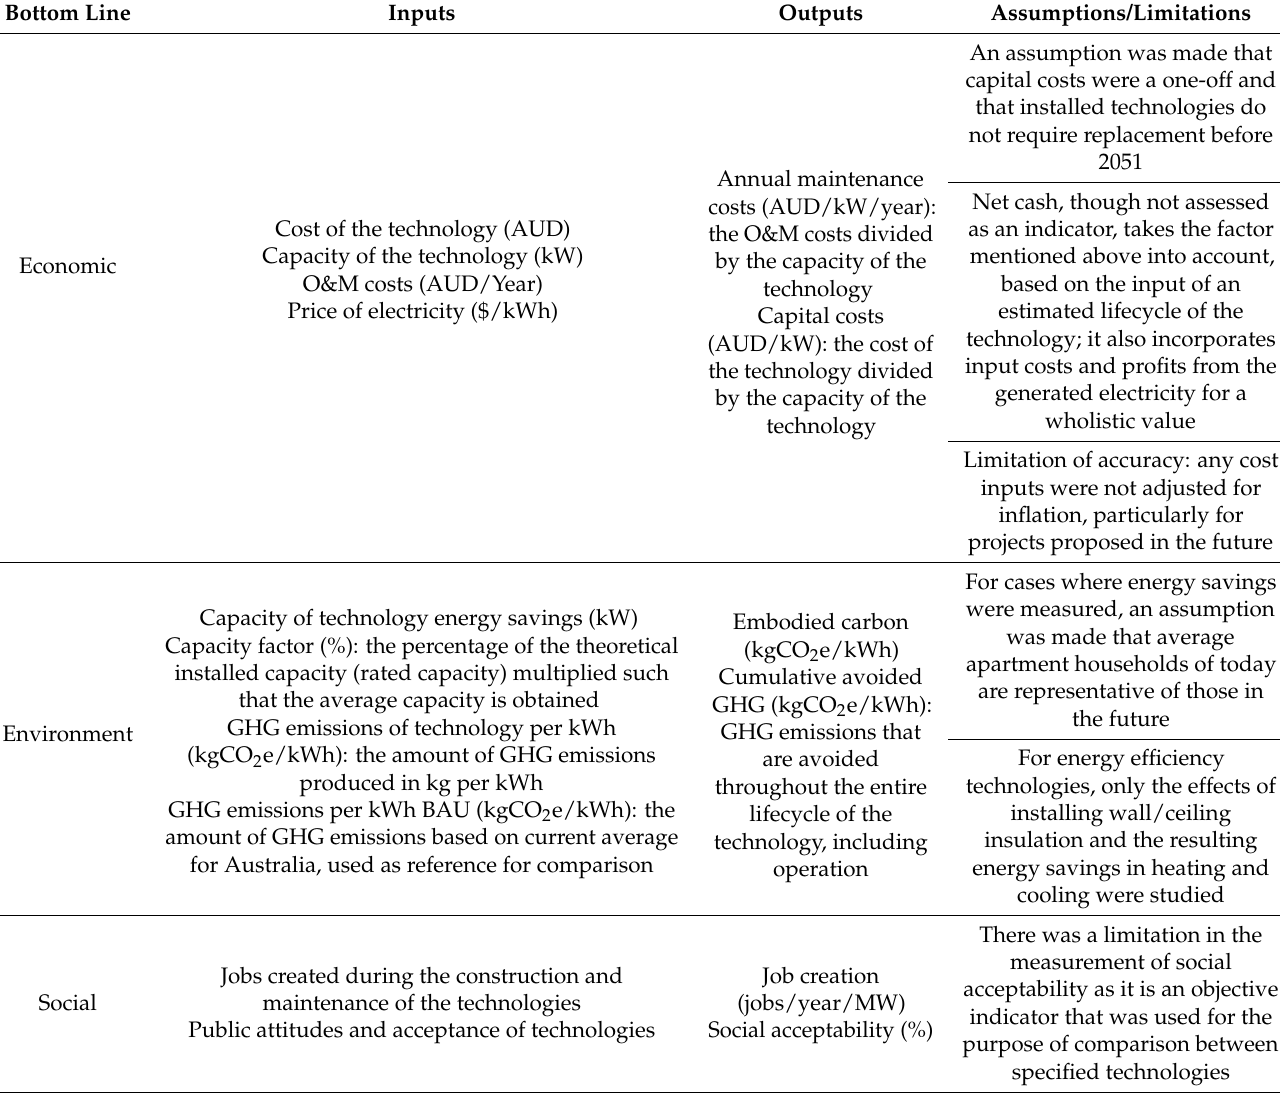
Table 3. The 3BL inputs, outputs and